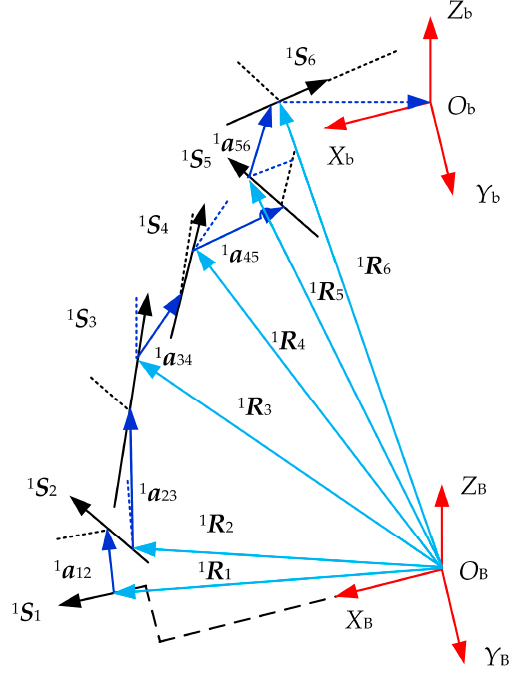
Figure 5. D-H coordinate frame of the i -th leg.